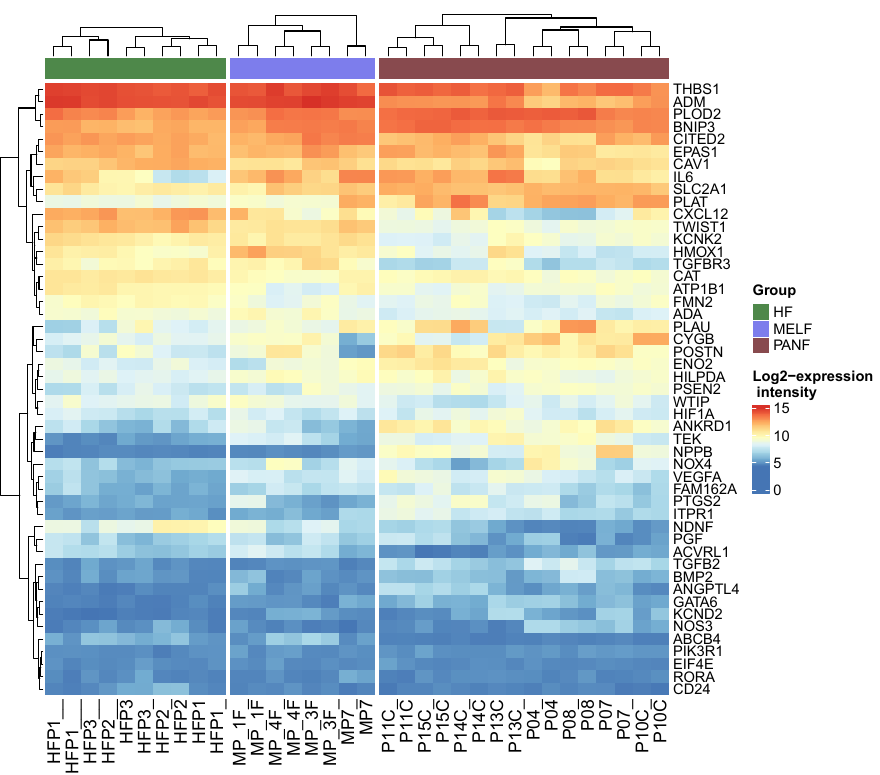
Figure 5. Heatmap demonstrating differential expression of genes influenced in hypoxia signalling (GO:0001666—response to hypoxia) in PANF, MELF CAFs, and HFs (normal fibroblasts). The gene encoding HIF-1 α expression was increased by 60% in PANF in contrast to HFs, but not reaching statistical significance.